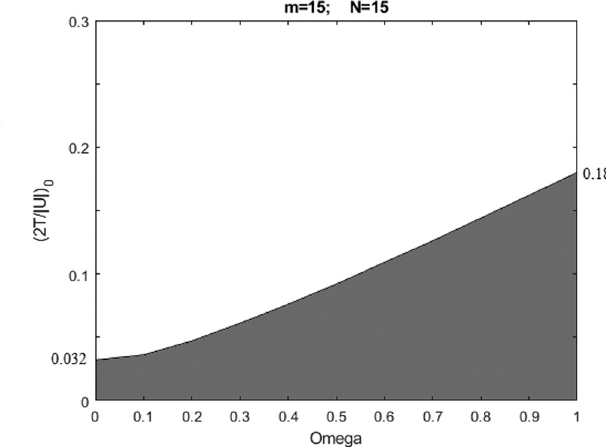
Figure 6: Critical dependence of the virial ratio on the rotation parameter for m 15 = ; N 15 = .